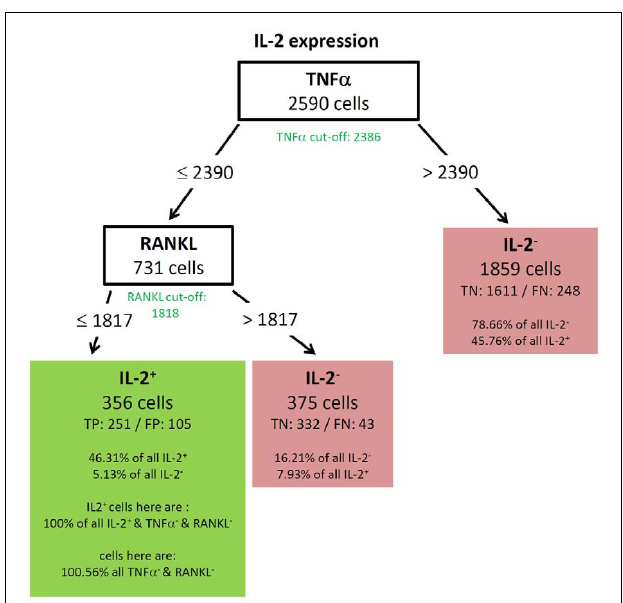
FIGURE 4 | Best decision tree for the classification of cells as positive or negative for IL-2 expression. Cells are classified based on the MFI values of firstTNF- α and second RANKL.The green colored cut-off values below the inner nodes, indicate that the split values are near the cut-off values.Therefore, these nodes dived the cells inTNF- α (respectively RANKL) negative and positive cells.The cells are routed to the right leaf if they do not expressTNF- α .This leaf captures 78.66% of all IL-2 negative cells, but also 45.76% of the IL-2 positive cells.The leaf in the middle classifies cells as IL-2 negative, which do not expressTNF- α but RANKL.The left node classifies cells as IL-2 positive and captures 46.31% of the IL-2 positive cells. It is stated that this node contains 100.56% of theTNF- α and RANKL negative cells.Thus, also cells which are positive forTNF- α and/or RANKL are in this leaf.This is due to the split values ofTNF- α .The split value is slightly above the real cut-off, therefore a fewTNF- α positive cells have been routed to the left and are therefore contained in the leftmost leaf. Since the split value of RANKL is below the cut-off value, no RANKL positive cells can be contained in the leftmost